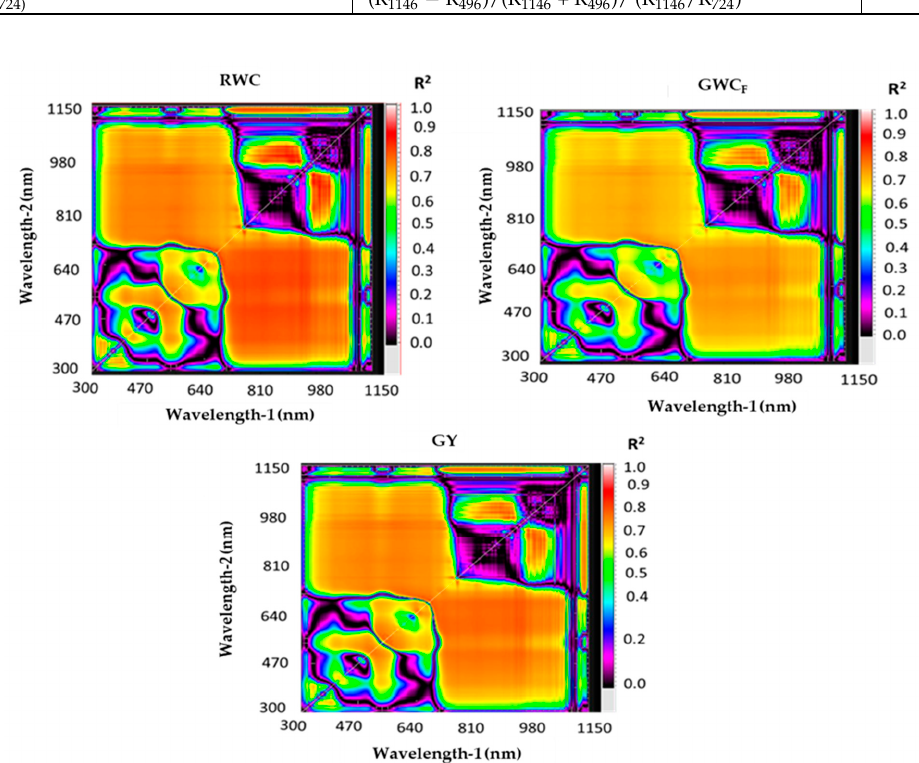
Figure 2. Two-dimensional (2-D) correlogram maps showing the coefficients of determination (R 2 ) between all the wavelength combinations in the full spectrum range (302–1148 nm) and the relative water content (RLWC), gravimetric water content on a fresh weight basis (GWC F ), and grain yield (GY) using the pooled data of the wheat cultivars, seasons, irrigation regimes, and replications.